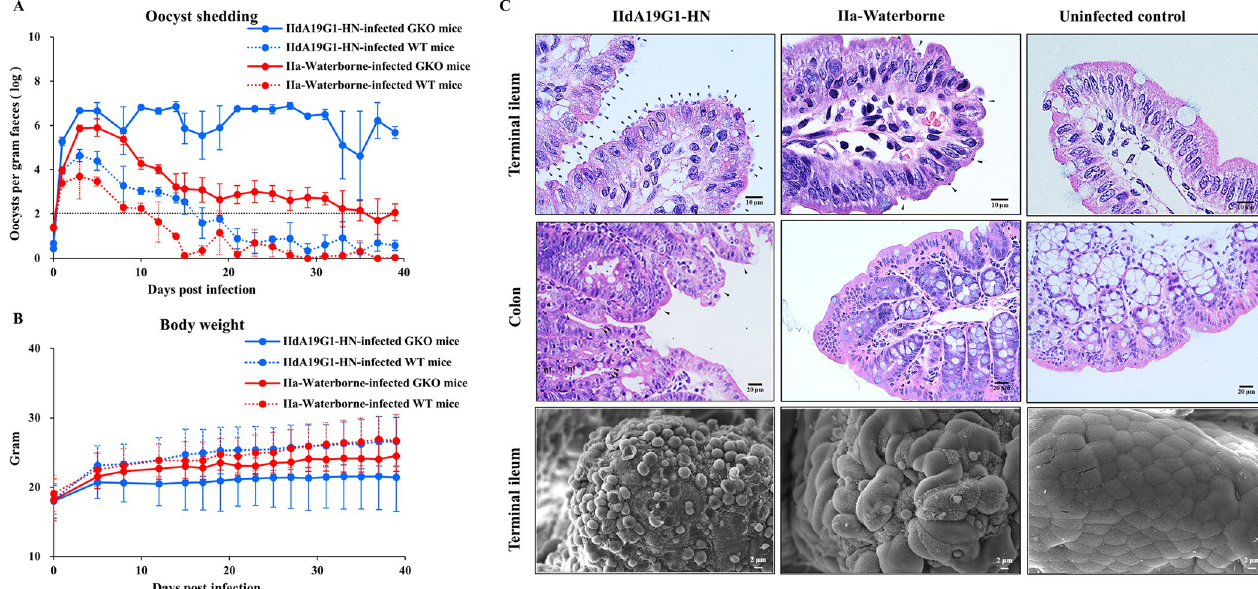
Fig 1. The interferon- γ -knockout (GKO) mouse model is susceptible to Cryptosporidium parvum isolates and can distinguish isolate-specific differences at the pathological level. (A) Oocyst shedding patterns of IIdA19G1-HN-infected GKO mice, IIdA19G1-HN-infected wild-type (WT) mice, IIa-Waterborne- infected GKO mice, and IIa-Waterborne-infected wild-type (WT) mice. Fecal samples were considered oocyst-negative when the number of OPG (log) was lower than 2.0 (indicated with a dotted line). (B) Body weight changes in these mice. (C) Hematoxylin and eosin microscopy (upper and middle panels) and scanning electron microscopy (lower panel) images of the terminal ileum and colon of GKO mice infected with IIdA19G1-HN and IIa-Waterborne isolates in comparison with the uninfected control (parasites are indicated with arrowheads).